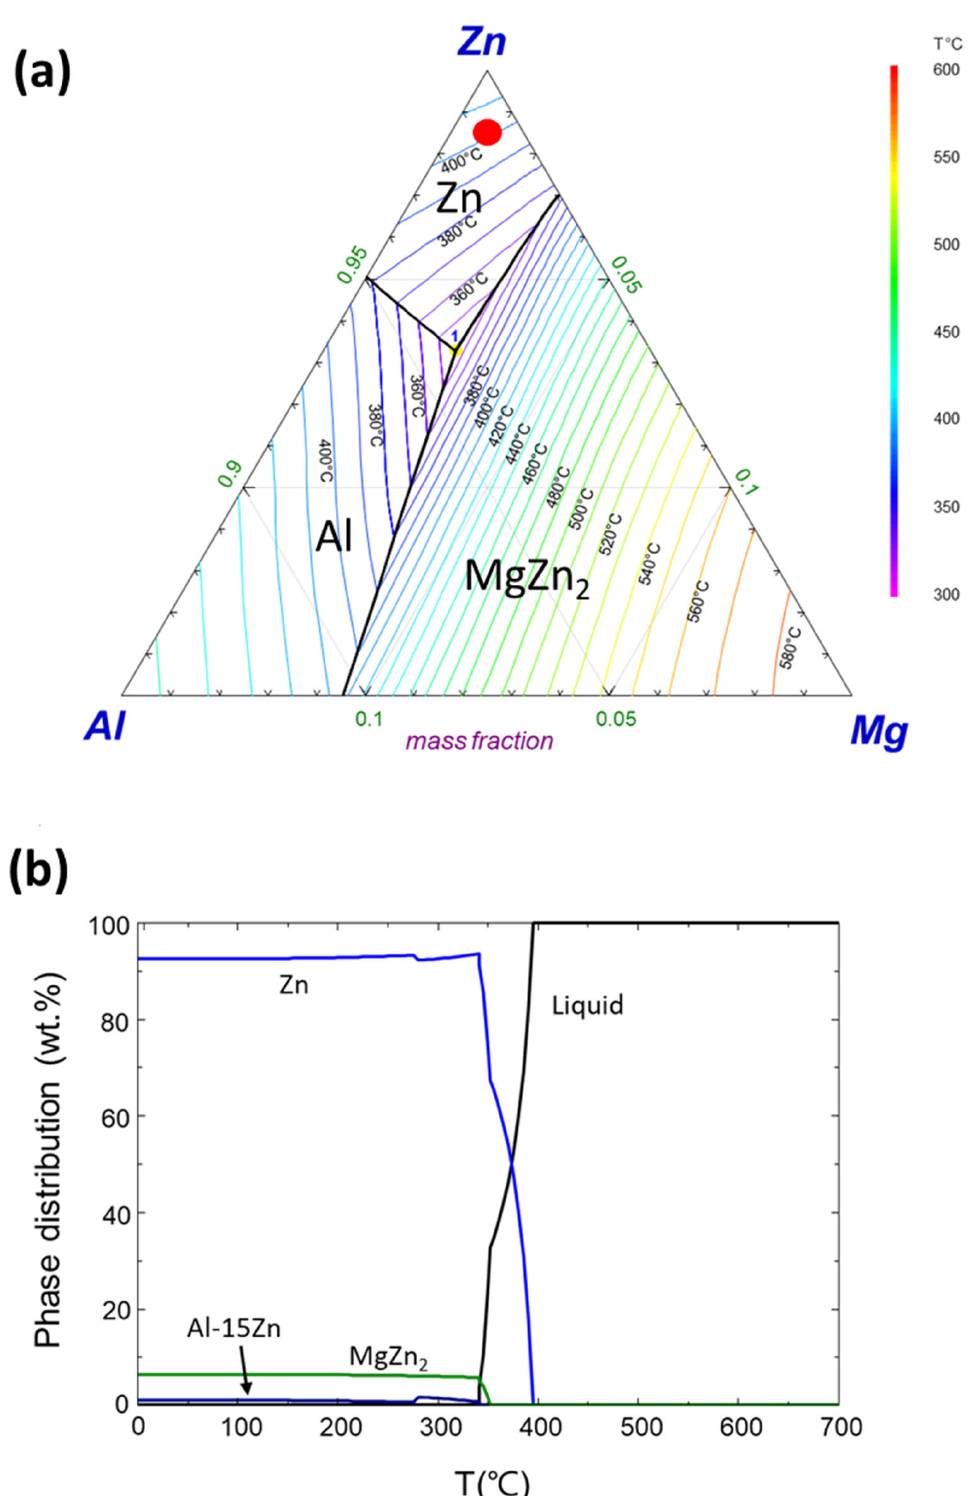
Figure 4. ( a ) Phase diagram (Zn: 85%–100%, Mg and Al: 0%–15%) and ( b ) solidification behaviors of Figure 4. (a) Phase diagram (Zn: 85%–100%, Mg and Al: 0%–15%) and (b) solidification behaviors the Zn–1 wt.% Mg–1 wt.% Al composition (Liquid → of the Zn–1 wt.% Mg–1 wt.% Al composition (Liquid → Solid).